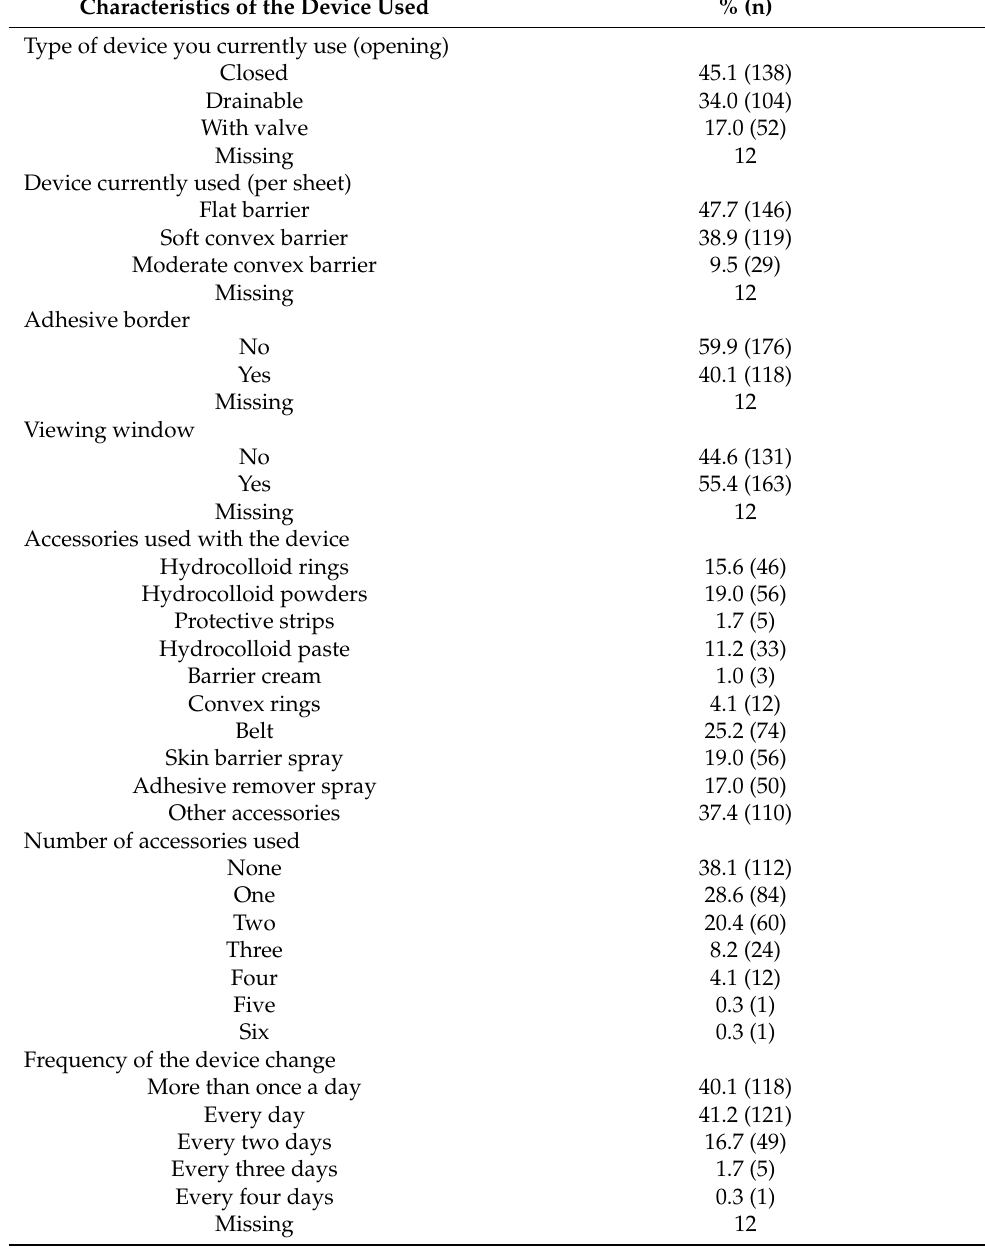
Table 3. Characteristics of the Moderma Flex device